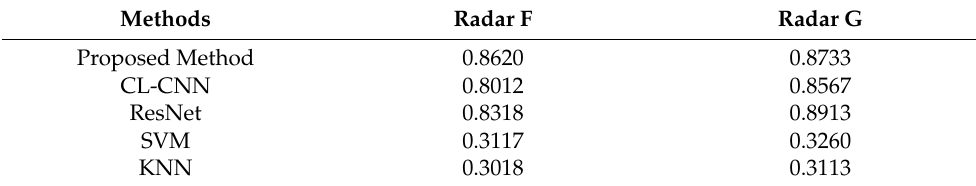
Table 5. Comparison of the classification accuracy of two radars by different methods ( − 5 dB).